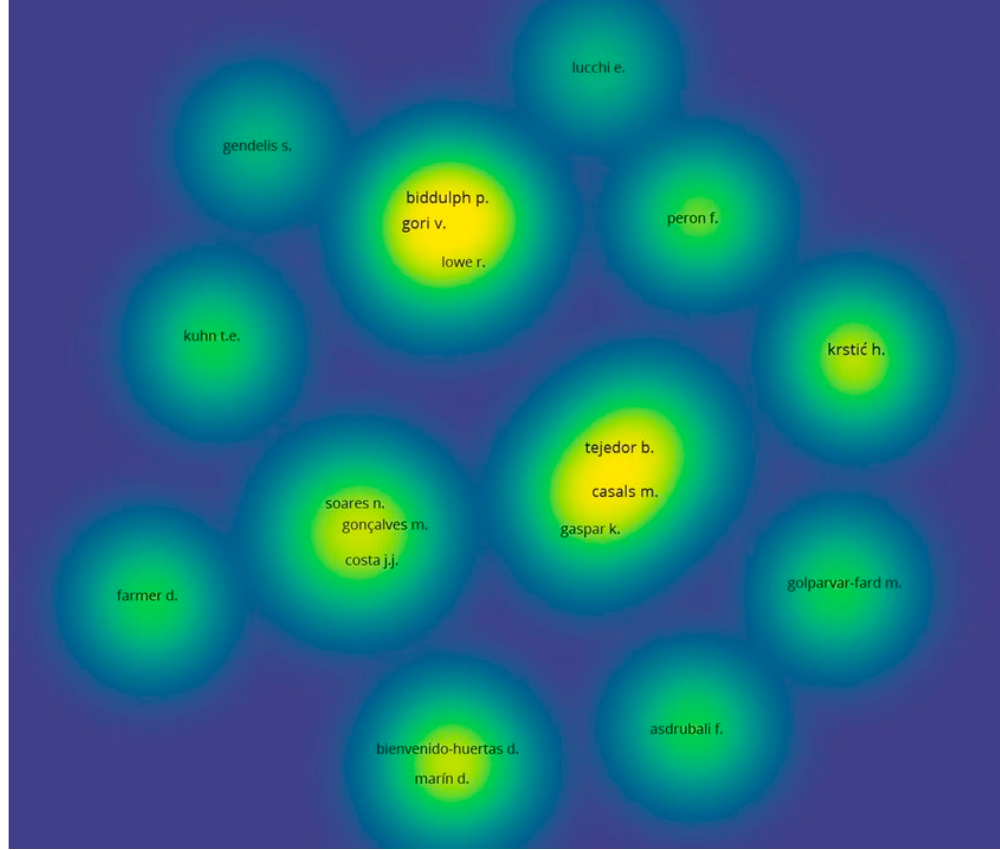
Figure 8. Density visualization of the authors with at least two publications on the topic “ thermal transmi tt ance measurement of building *” (source: authors’ elaboration using VOSviewer, based on Scopus data).